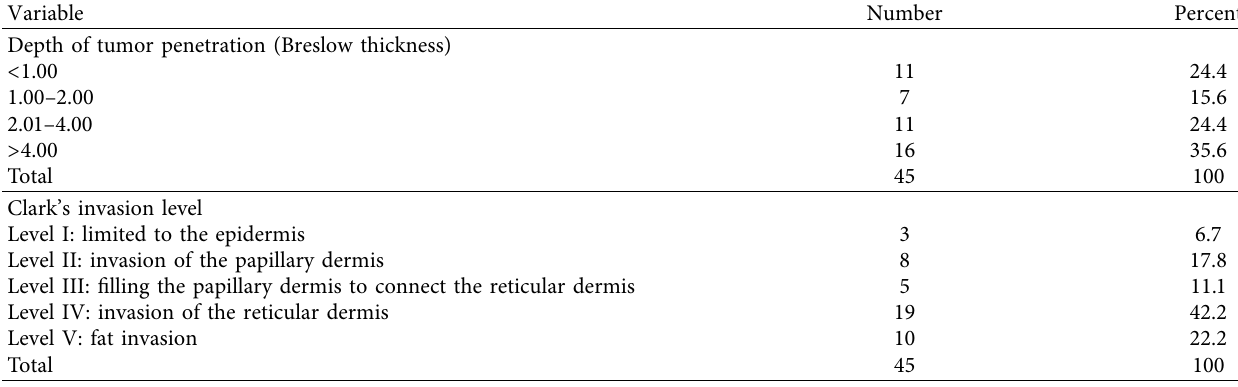
Table 2: Frequency distribution of Breslow thickness and tumor invasion level.